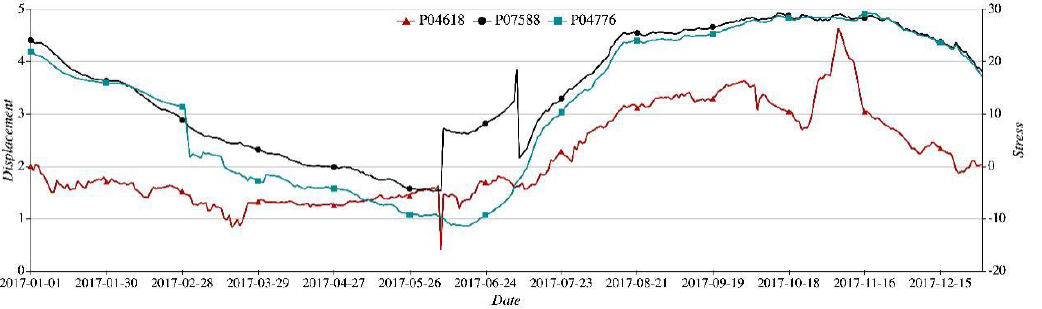
Figure 8. Time sequence of key nodes P04618, P07588, and P04776.